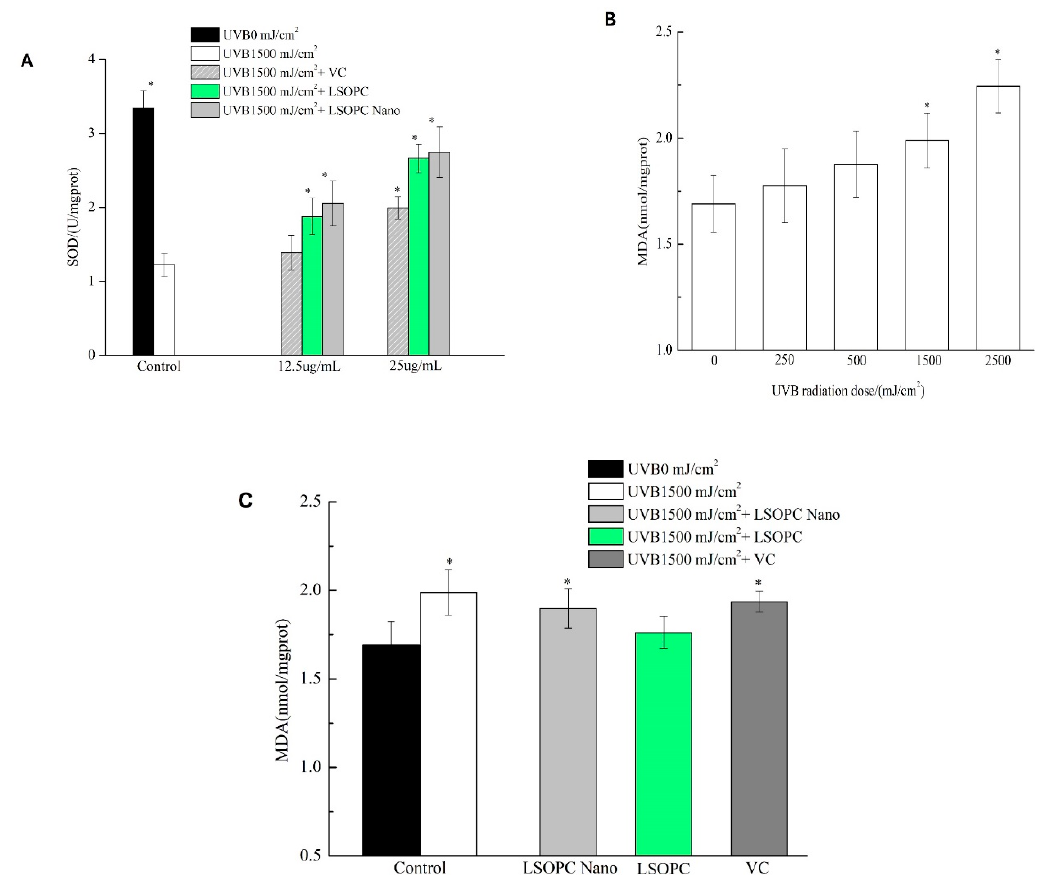
Figure 5. Superoxide dismutase (SOD) in HFF-1 cell before and after UVB irradiation with different concentrations of LSOPC, LSOPC Nano, and Vc, respectively ( A ); malonaldehyde (MDA) in HFF-1 cell under different doses of UVB radiation ( B ); MDA in HFF-1 cell before and after 1500 mJ/cm 2 UVB irradiation with LSOPC, LSOPC Nano, and Vc (12.5 μ g/mL), respectively ( C ).